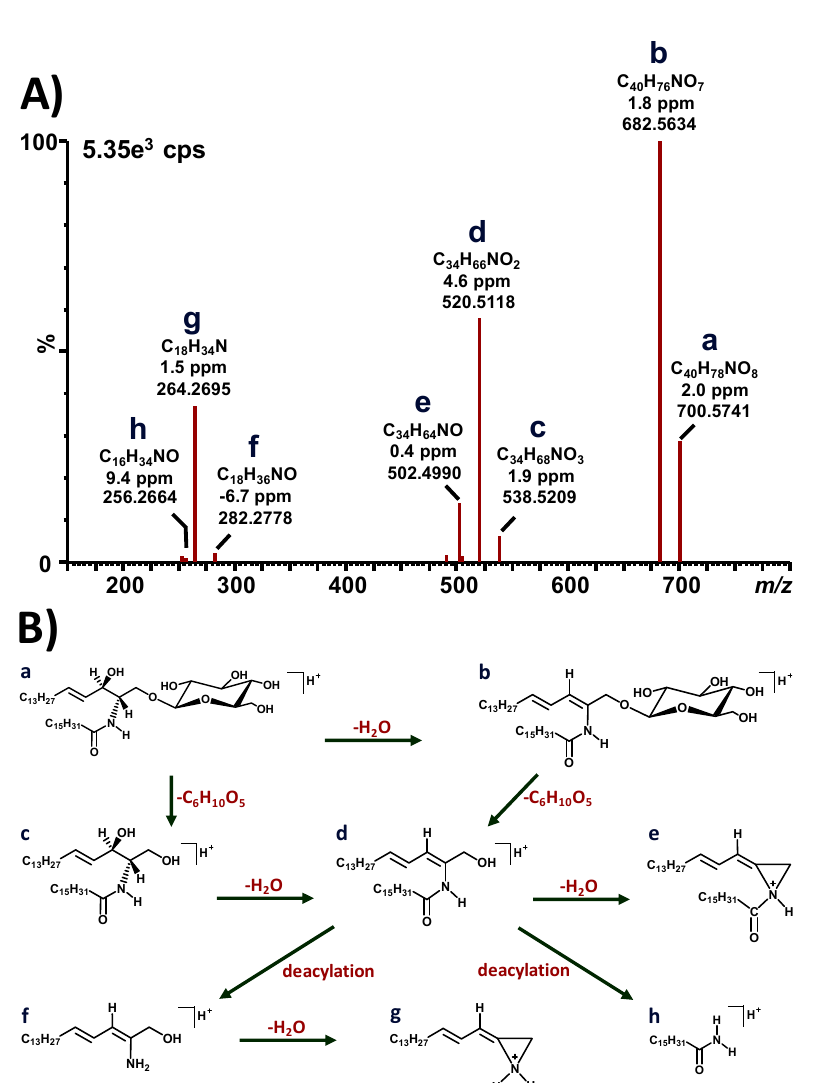
Figure 3. ( A ) Quadrupole time-of-flight (Q-tof) fragmentation spectrum of GluCer(C16:0) ( m / z 700.57) in vitreous humor of the Gaucher type 3 patient. Deviations from the theoretical masses written in parts per million (ppm). Collision energy ramp: 5–35 V. Cps, counts per second. ( B ) Fragmentation mechanism of GluCer(C16:0) corresponding to the spectrum in ( A ).